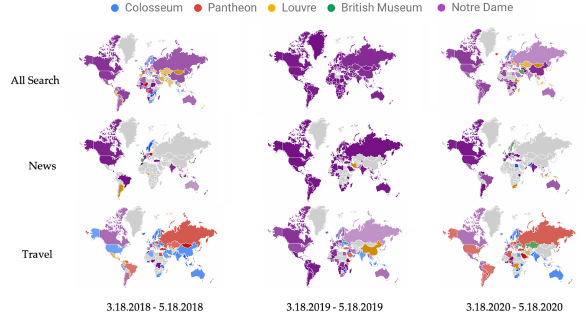
Figure 2. The heatmaps showing relative search interest for countries and regions globally of five heritage properties within two months (March 18 to May 18) in 2018-2020 on Google Trend search engine under the search categories of “All Search”, “News”, and “Travel”,